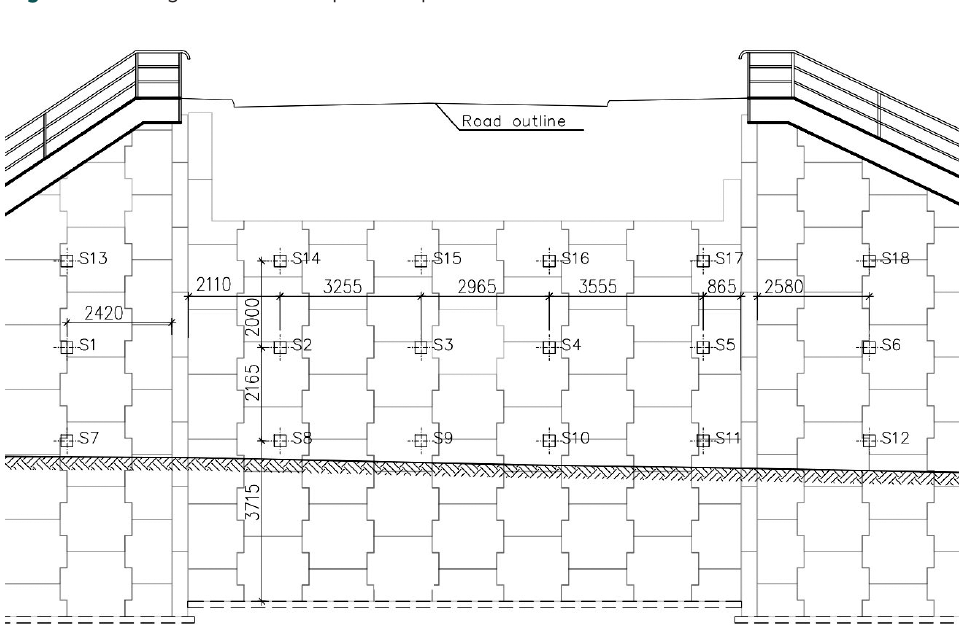
Figure 6. Arrangement of control points on front wall and wings of reinforced earth